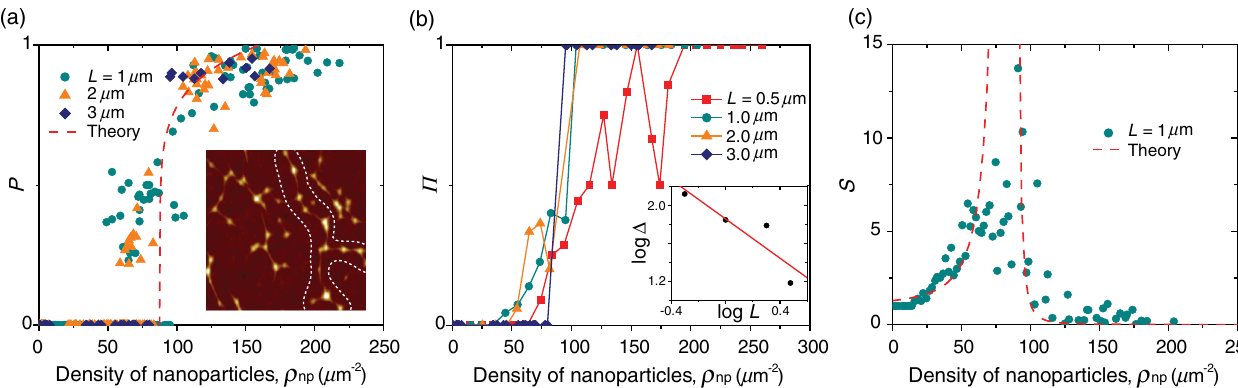
FIG. 5. (a) P as a function of nanoparticle density for L ¼ 1 , 2, and 3 (cid:3) m . The inset is an AFM image ( 1 (cid:2) 1 (cid:3) m 2 ) of graphene on nanoparticles with a density of 57 (cid:3) m 2 , showing the percolating cluster highlighted by the dashed curve. (b) (cid:3) as a function the SiO 2 of the density of nanoparticles for L ¼ 0 : 5 , 1, 2, and 3 (cid:3) m . Points for L ¼ 0 : 5 , 1, and 2 (cid:3) m represent averages in a bin of 10 (cid:3) m (cid:3) 2 . The inset is a plot of log(cid:4) as a function of log L ; the red line indicates a best-fit power exponent of (cid:3) 1 : 0 . (c) The mean finite cluster size S as a function of the density of nanoparticles (points represent averages in a bin of 2 (cid:3) m (cid:3) 2 ). The red dashed line is the theoretical expectation (described in